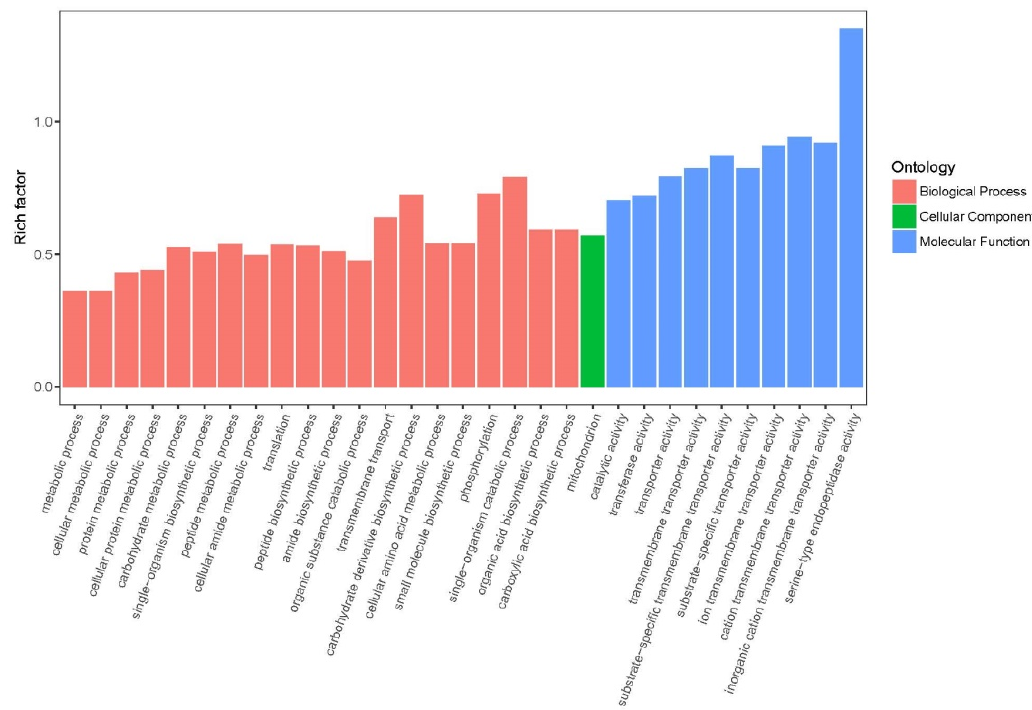
Figure 3. Gene ontology (GO) classification analysis based on DEGs induced by COS under − 4 °C treatment. The horizontal coordinates indicate GO terms, the longitudinal coordinates indicate rich factor, rich factor represents the ratio between the number of different genes enriched in the term and the background genes in GO term.